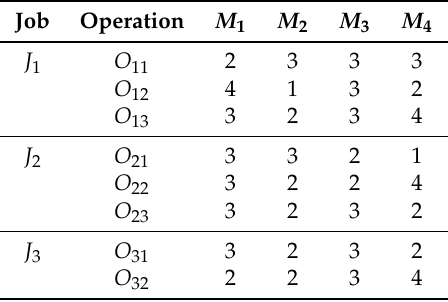
Table 3. An instance of flexible job shop